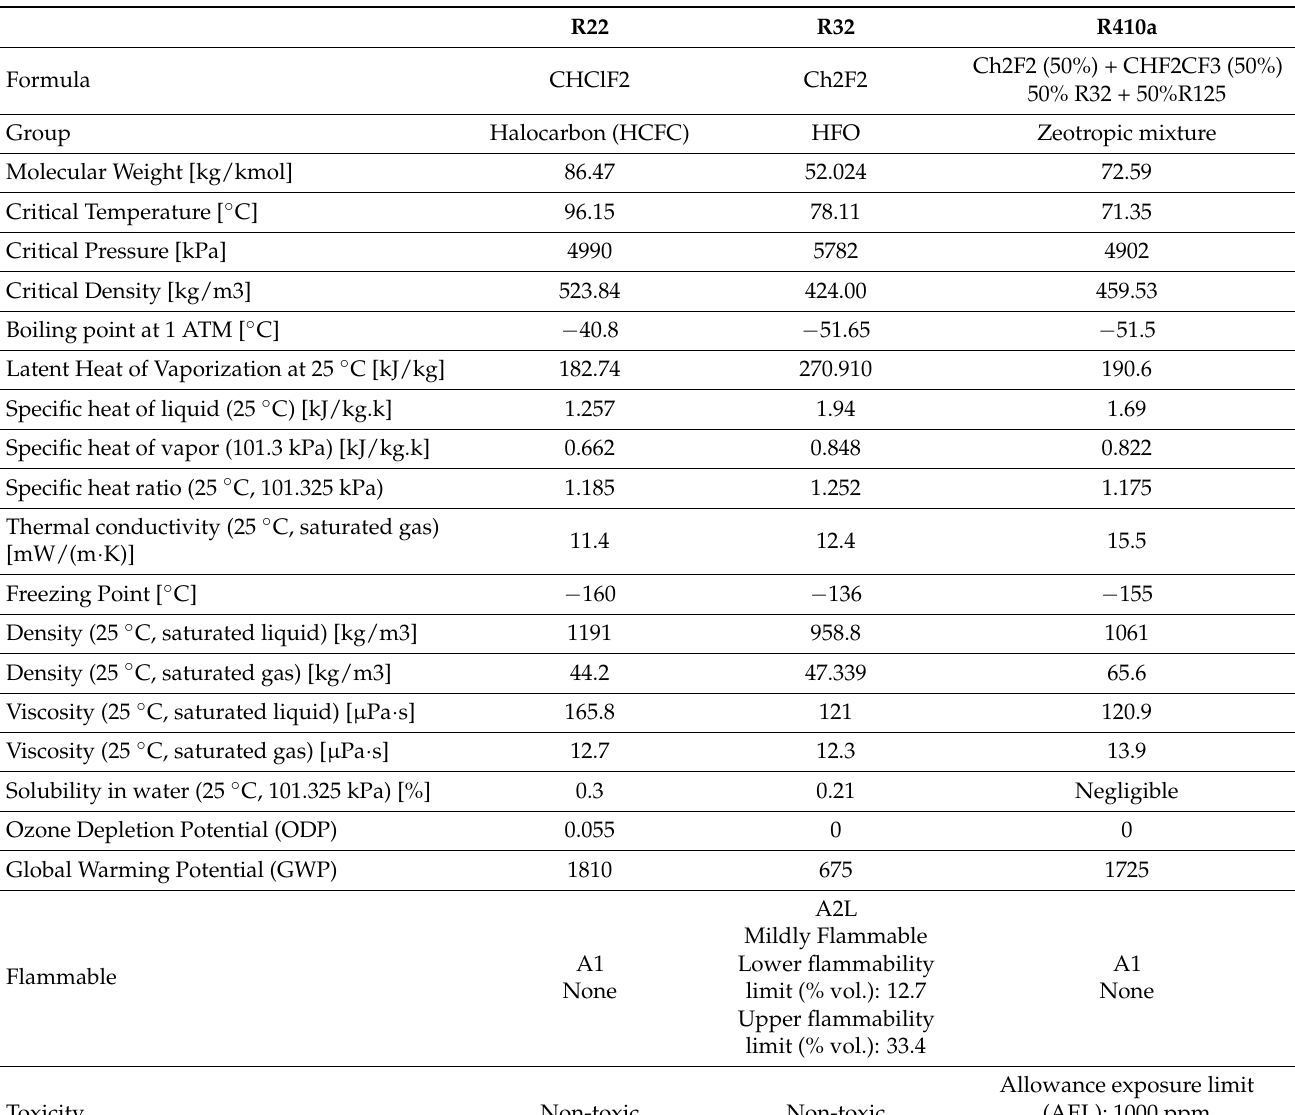
Table 3. The main physical and chemical characteristics of the selected refrigerants.